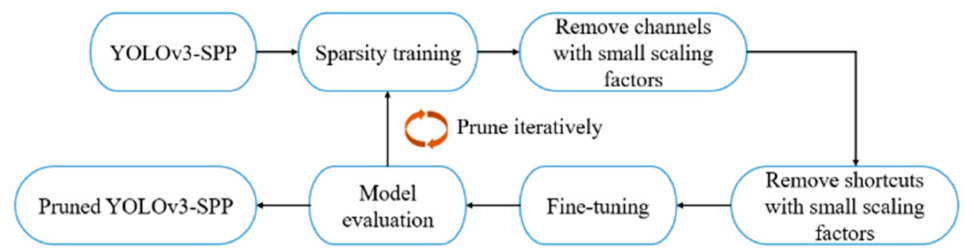
Figure 4. Improved YOLOv3 model cropping flow chart. The main parameters used in pruning YOLOv3-SPP3 are shown in Table